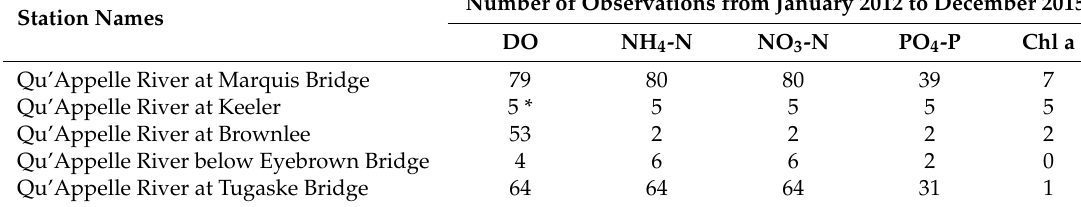
Table 1. Water quality monitoring stations and the number of observations used for calibration and